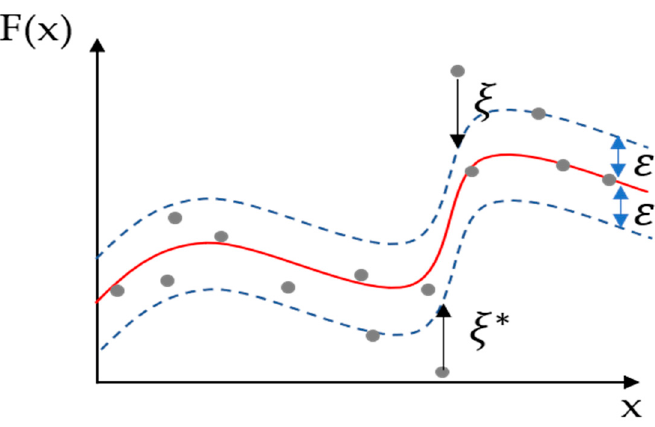
Figure 2. The notation of ε -insensitive loss function in SVR.